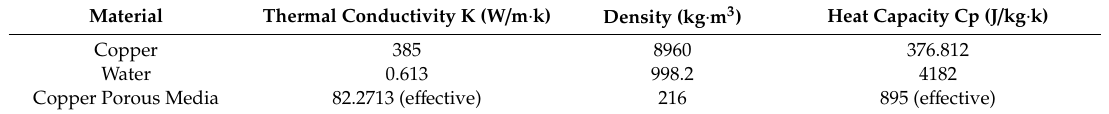
Table 1. Physical Property of the material used in the study.